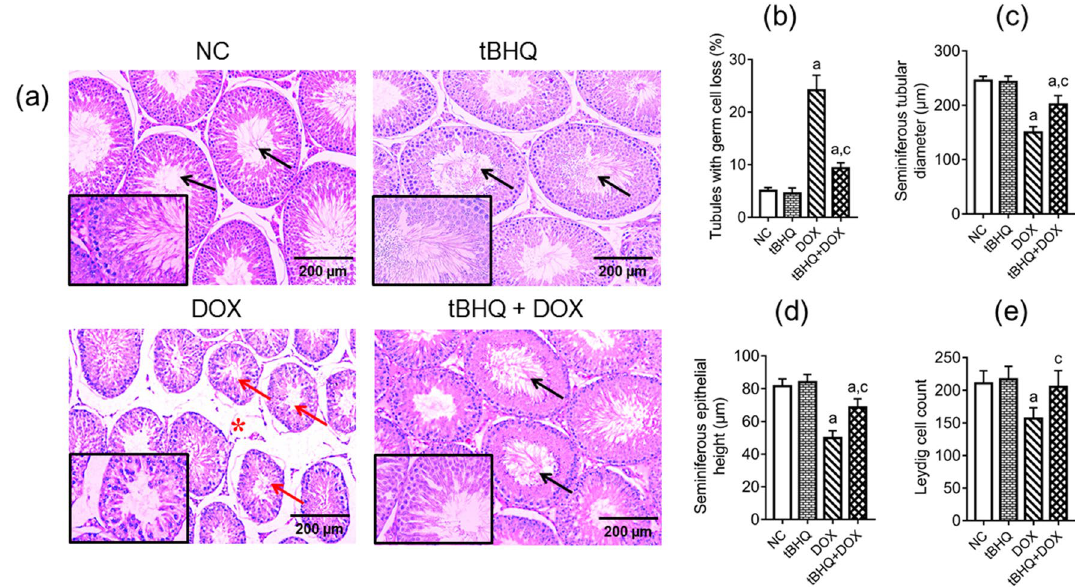
Figure 1. Effect of tBHQ on the testicular structure of DOX-treated rats. ( a ) Representative H&E staining light microscope images of testicular tissue (magnification: × 100, scale bar: 200 μm, and × 400, scale bar: 50 µm for representative images with black borders). DOX decreased seminiferous tubular diameter giving rise to large intertubular spaces (red asterisks). Numerous seminiferous tubules in DOX group had germ cell loss (red arrows) compared to the NC and tBHQ-treated groups showing several tubules with complete spermatogenesis and sperm cells in the lumen (black arrows). NC: normal control, tBHQ: tert-butylhydroquinone, DOX: doxorubicin, tBHQ + DOX: tert-butylhydroquinone + doxorubicin. Numerical data show seminiferous tubules with germ cell loss ( b ), seminiferous tubular diameter ( c ), seminiferous epithelial height ( d ), and Leydig cell count ( e ), respectively. Values are mean ± SD, n = 6/group. a p < 0.05 versus NC; c p < 0.05 versus DOX (One-way ANOVA with Tukey’s post-hoc test).